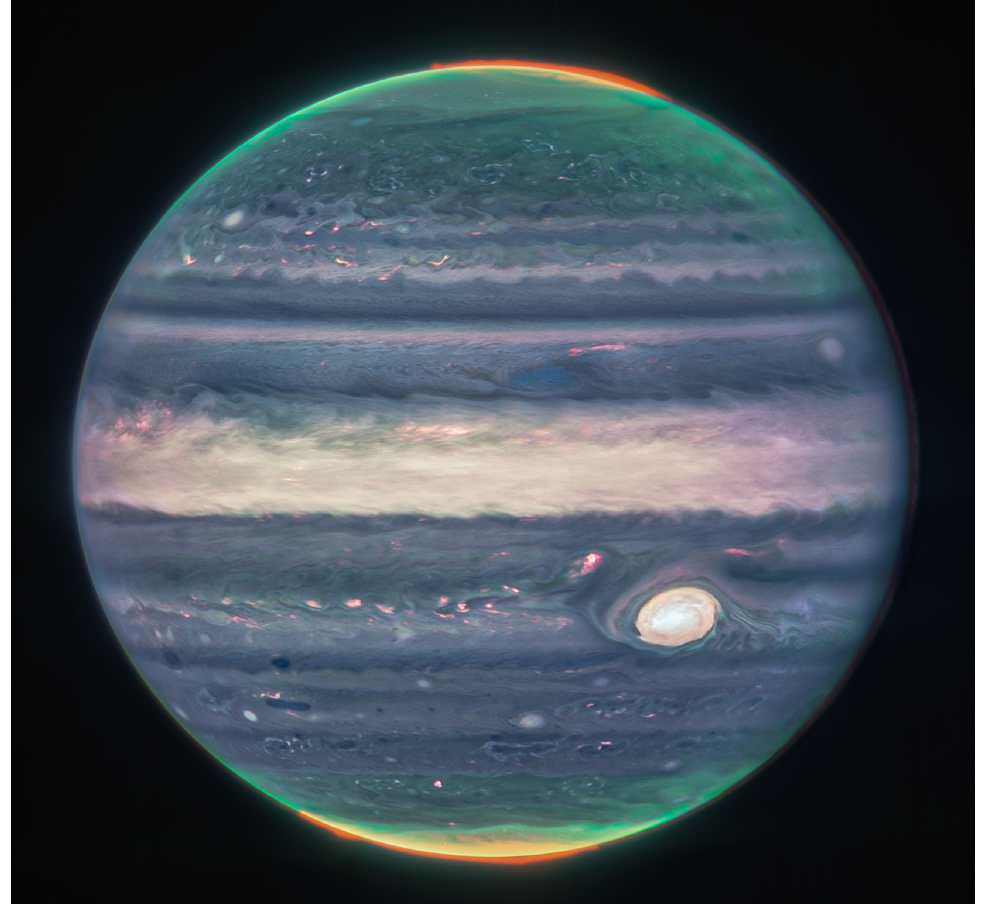
Figure 10. JWST composite image of Jupiter using three NIRCam filters—F360M (3.6 µ m; mapped to red), F212N (2.12 µ m; mapped to yellow-green), and F150W2 (1.5 µ m; mapped to cyan). Each image was de-rotated before combining in order to account for the planet’s rotation. Credit: NASA, ESA, CSA, Jupiter ERS Team; image processing by Judy